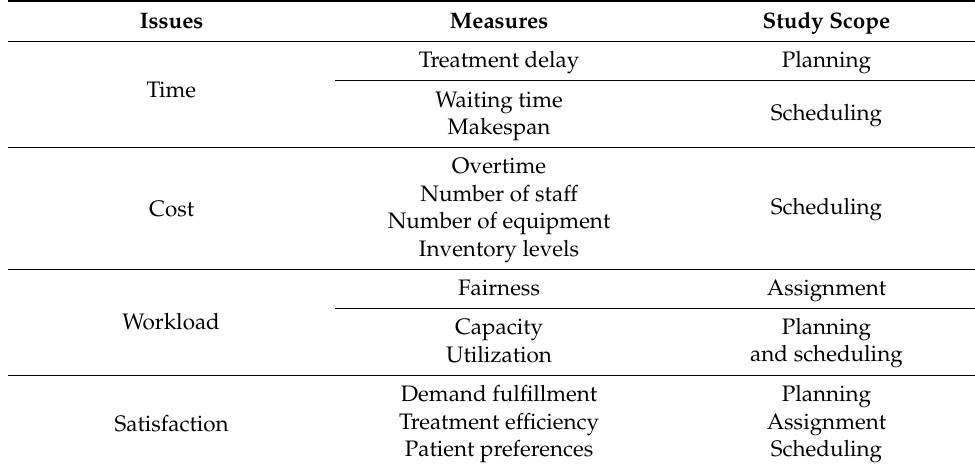
Table 1. OCP issues and performance